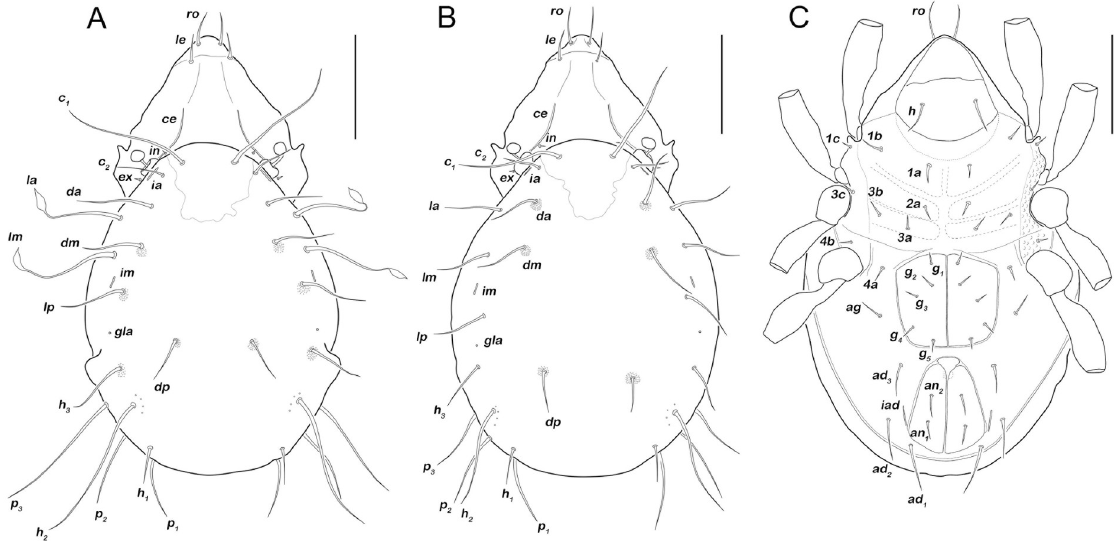
Fig 6. Fortuynia antillea sp. nov. morphology. A. Male dorsal view. B. Female dorsal view. C. Female ventral view (as there are no sexually dimorphic characters on the ventral aspect, apart from genital orifice size, this depiction is also valid for male). Scale bars = 100 μ